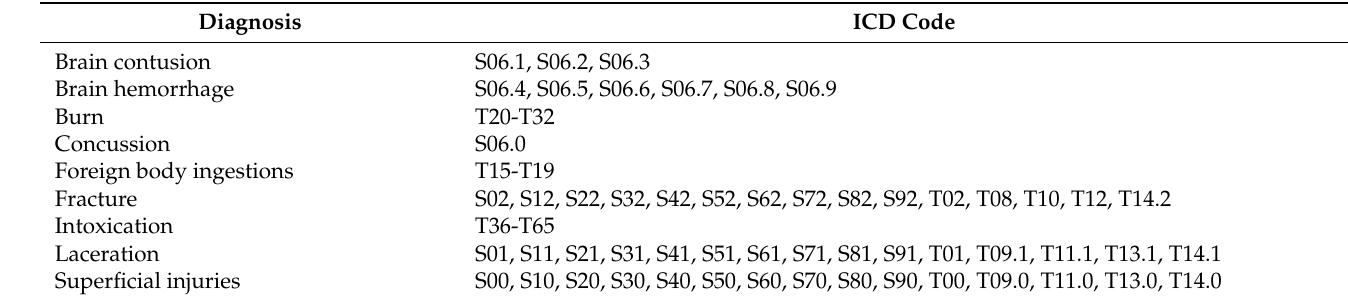
Table 1. Subgroups of injury-related disease by ICD-10 code.